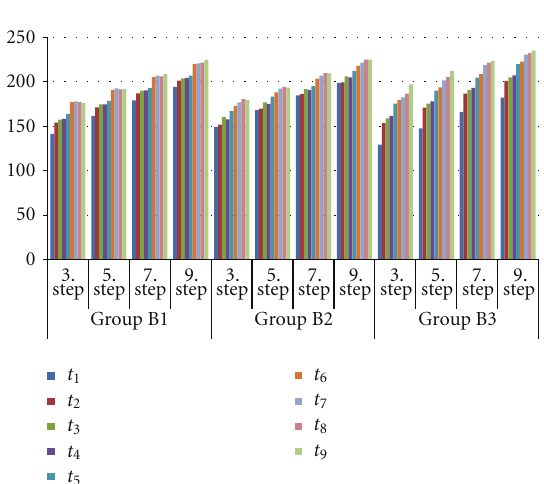
Figure 4: The MGVs of the three subgroups of the Digora Optime plates according to delay in scanning